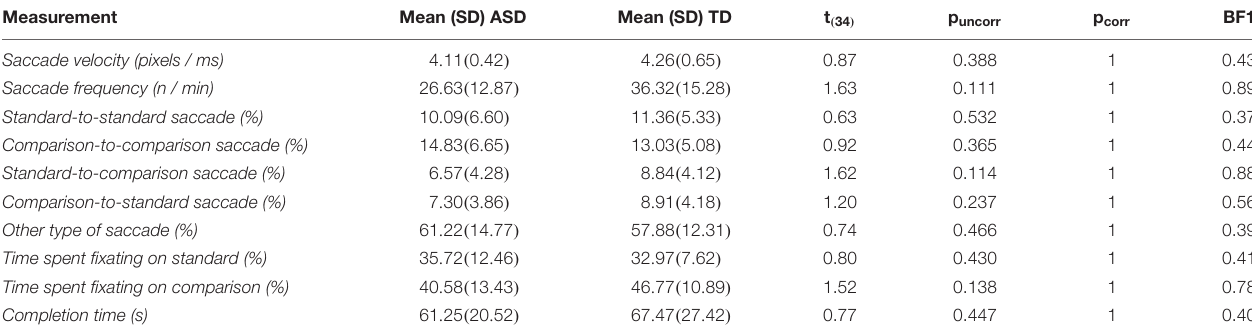
TABLE 3 | Eye-tracking measures between the ASD and TD groups.